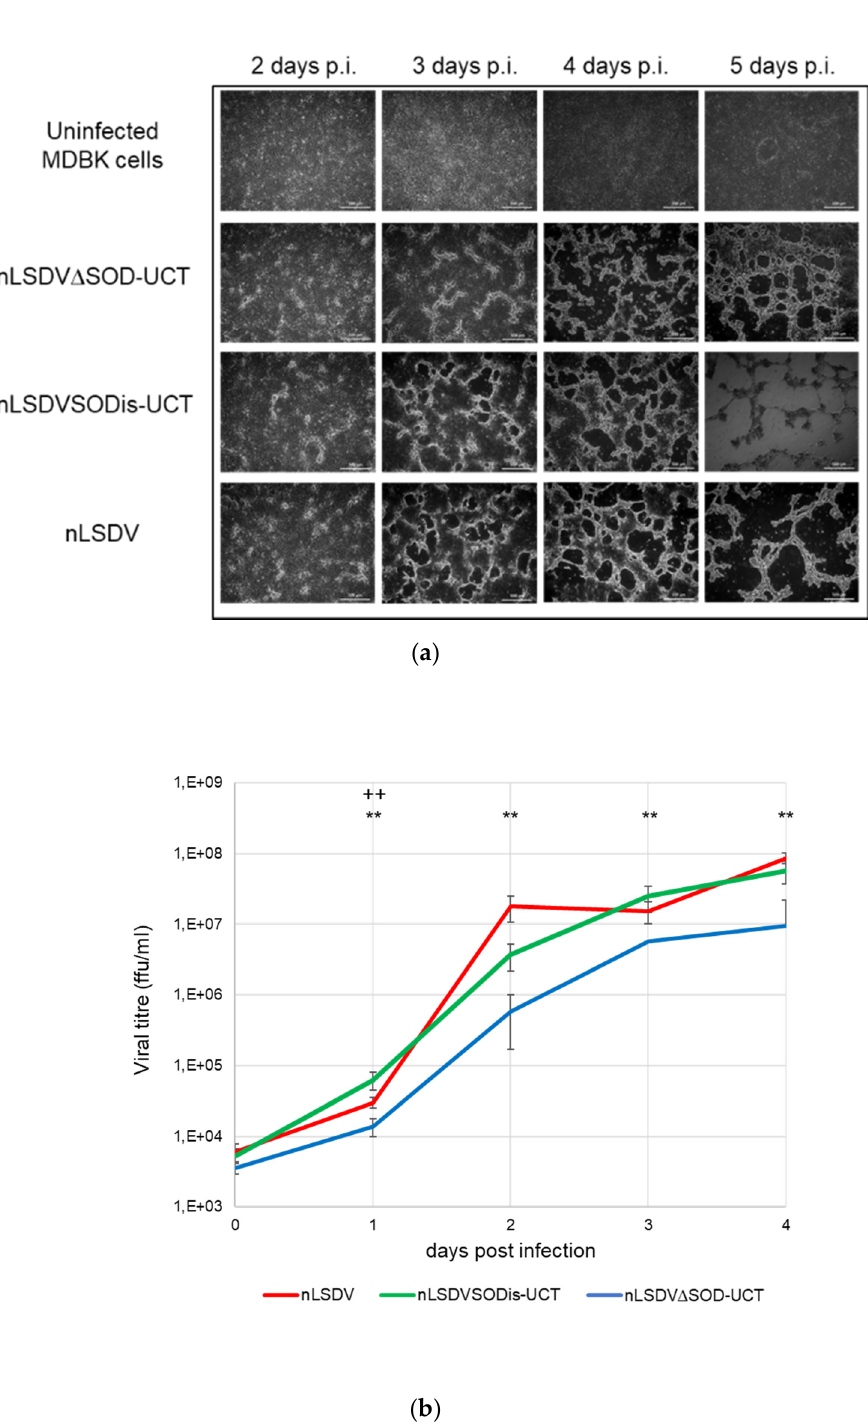
Figure 3. Growth in MDBK cells ( a ) MDBK cells uninfected or infected with nLSDV ∆ SOD-UCT, nLSDVSODis-UCT or nLSDV at an multiplicity of infection (MOI) of 0.015. Monochrome light inverted microscopic images were taken at time points as indicated; ( b ) growth curves of nLSDV (red), nLSDVSODis-UCT (green) and nLSDV ∆ SOD-UCT (blue) in MDBK cells. Cells were infected at a MOI of 0.015 in triplicate and lysates were prepared 2 h post infection and at subsequent 1 day intervals. Titrations were performed to determine the TCID50 in MDBK cells; titers were converted to focus forming units per ml (ffu/mL). Data were analyzed by one-way ANOVA and post-hoc T-test. Data points denote mean and error bars SEM. ** denotes significant difference between nLSDV and nLSDV ∆ SOD-UCT at p < 0.01; ++ denotes significant difference between nLSDV ∆ SOD-UCT and nLSDVSODis-UCT at p < 0.01.